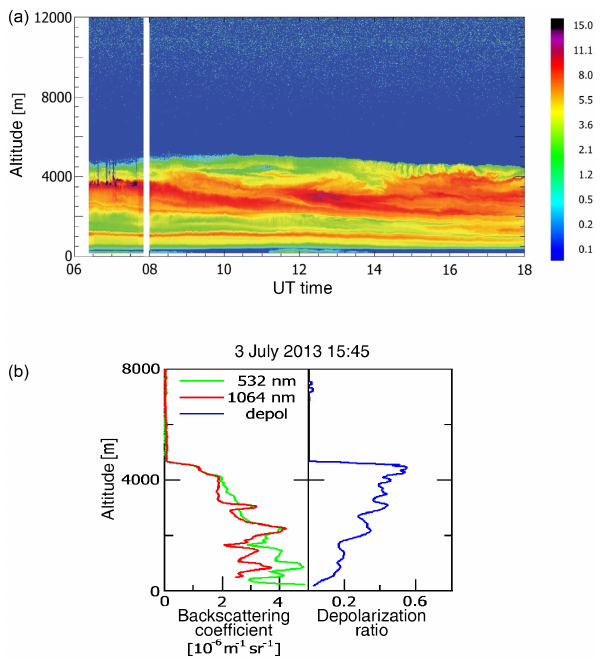
Figure 23. (a) Time evolution of the vertical profile of the aerosol backscattering coefficient at 1064nm at Lampedusa on 3 July 2013. The color scale is in units of 10 − 7 m − 1 sr − 1 . (b) Vertical pro- file of aerosol backscattering coefficient at two wavelengths and of aerosol depolarization ratio at 355nm measured at Lampedusa on 3 July 2013 at